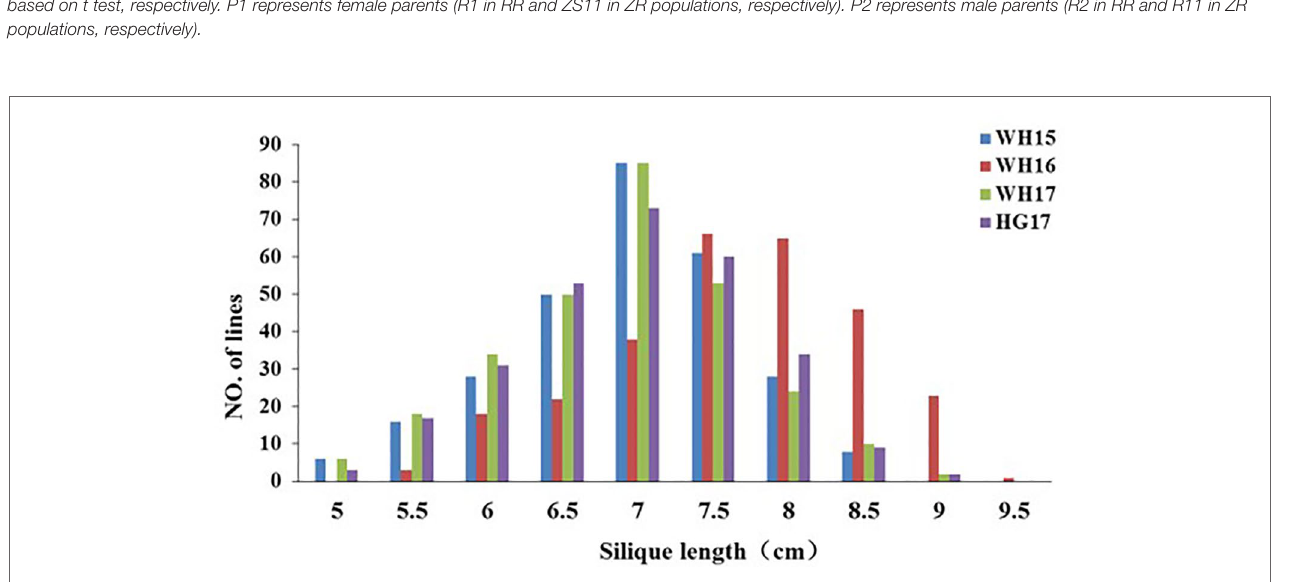
Frontiers in Plant Science |